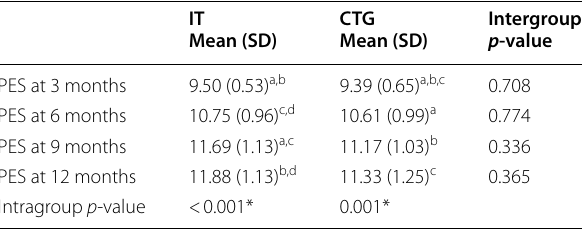
Intragroup time points with the same letter indicate statistical